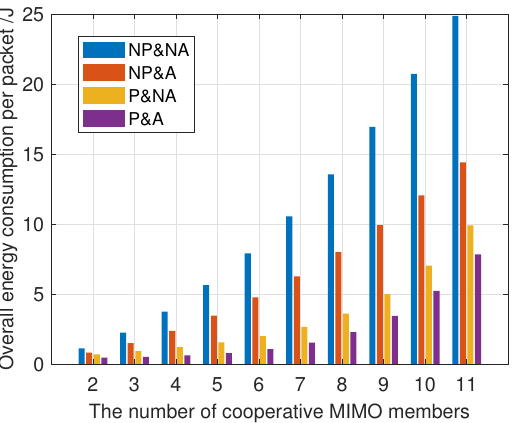
Figure 4. The overall energy consumption per packet with different numbers of cooperative MIMO